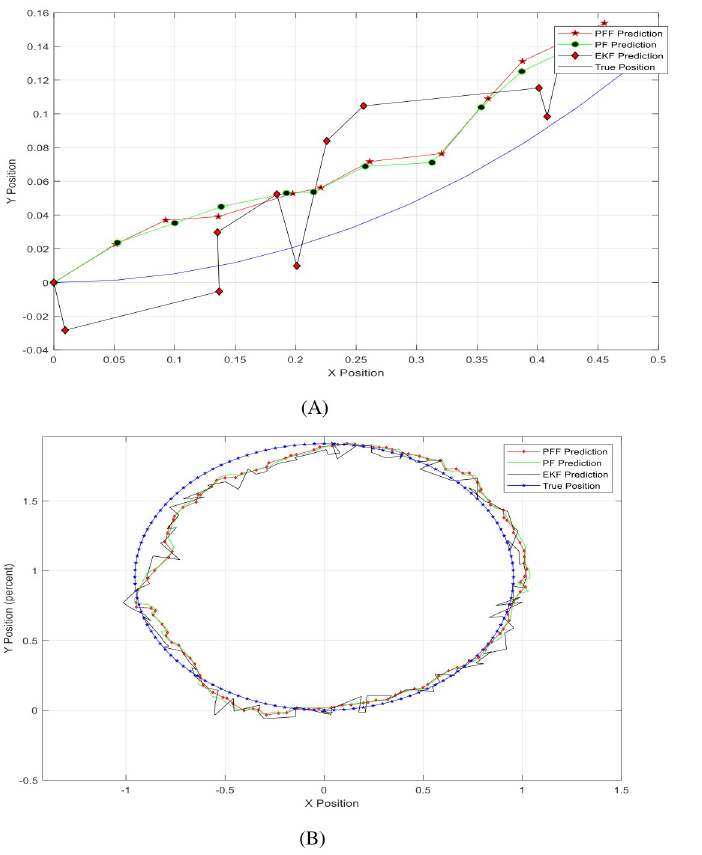
Fig 9. A-SLAM position predictions. (A) Short-run/zoomed version—2D. (B) Full path—2D.